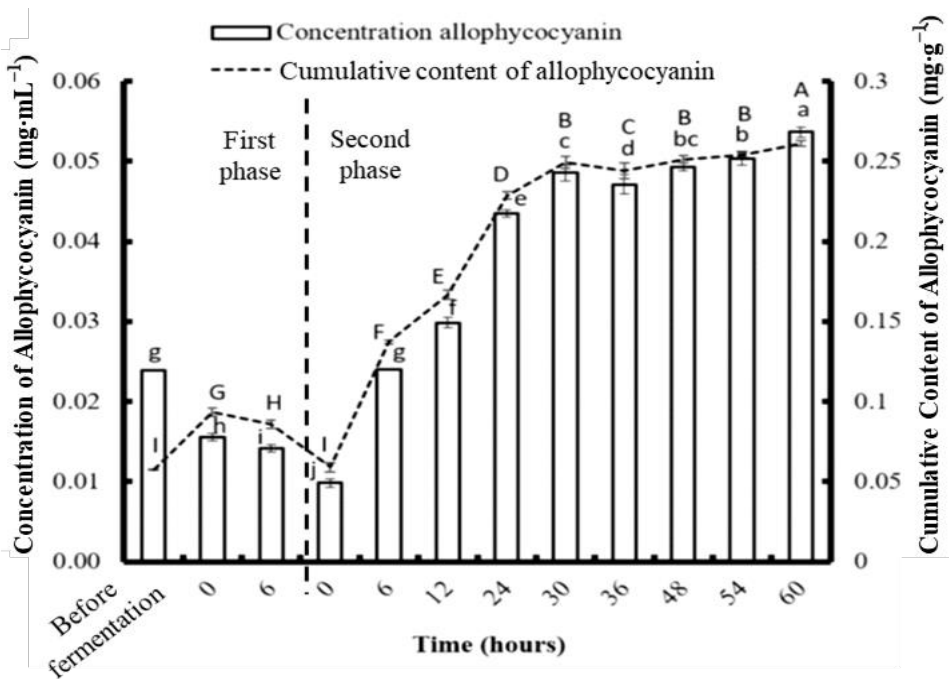
Figure 8. The effect of different fermentation times on the concentration and content of allo- phycocyanin in Colaconema formosanum before and during two-phase fermentation with Pseudoal- teromonas haloplanktis , ATCC 14393. Lowercase letters (a, b, c . . . ): concentration of allophycocyanin between each fermentation time; uppercase letters (A, B, C . . . ): content of allophycocyanin between each fermentation time ( n = 3, Duncan’s test, p <